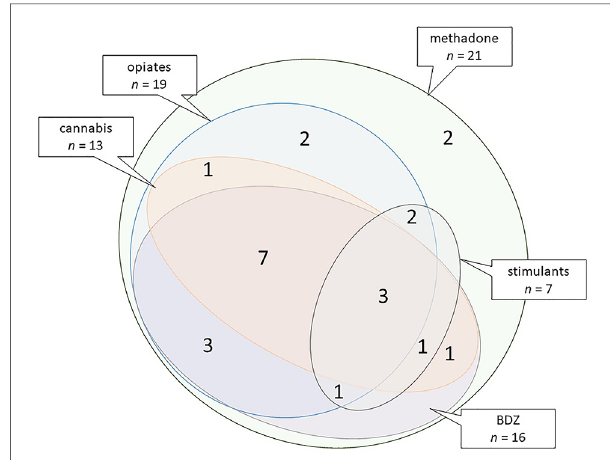
FIGURE 1 Euler diagram illustrating combinations of polydrug exposure based on combined exposure data for the 21 exposed children. Stimulants: cocaine and/or amphetamines. BDZ,